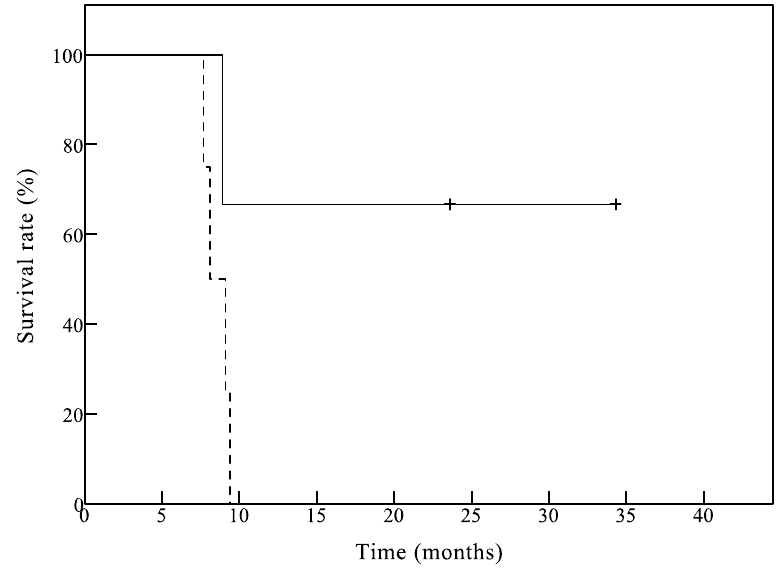
Figure 3. Overall survival of glioblastoma patients with or without bevacizumab. The median overall survival time (mOS) was 23.6 months in three patients that did not receive bevacizumab before enrollment (solid line). The mOS was 8.6 months in four patients treated with bevacizumab before enrollment (dotted line).